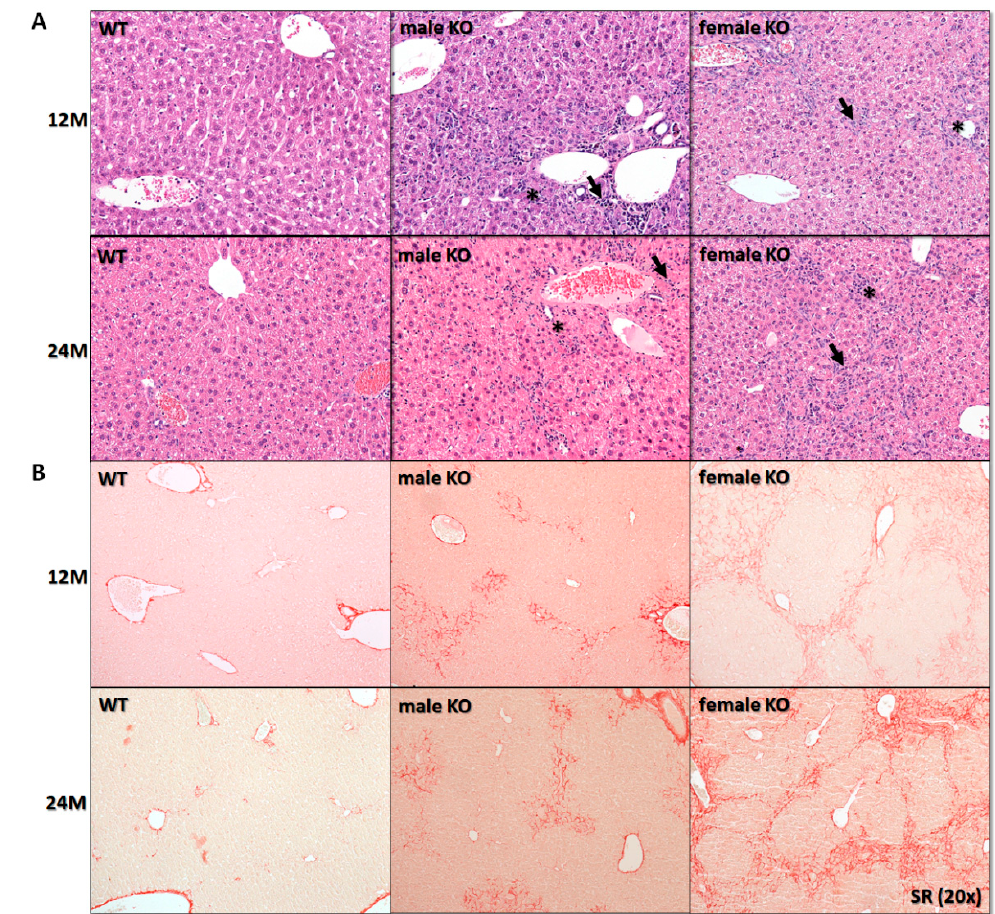
Figure 1. Blocking cholesterol synthesis due to depletion of Cyp51 resulted in histological alterations of the liver, most prominent in females. ( A ) Histological examination revealed ductular reaction (*) and inflammation ( → ) (H&E, original magnification ×200), N = 5–10. ( B ) Sirius red stain (SR, original magnification ×200) showed more pronounced fibrosis in female transgenic mice, N = 3–5. M, month; KO, Cyp51 KO; WT, wild-type.